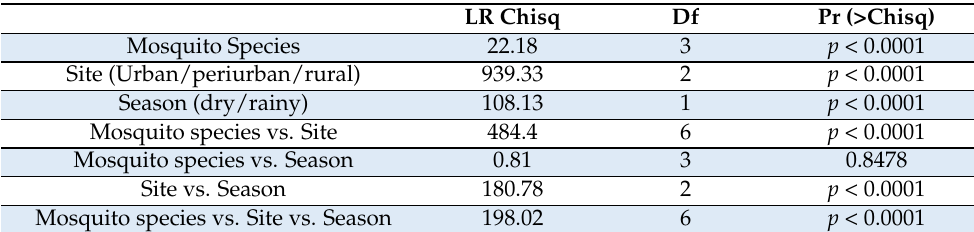
Table 2. Assessment of the correlation between sites breeding habitats, seasons and mosquito species abundance and distribution using generalized linear